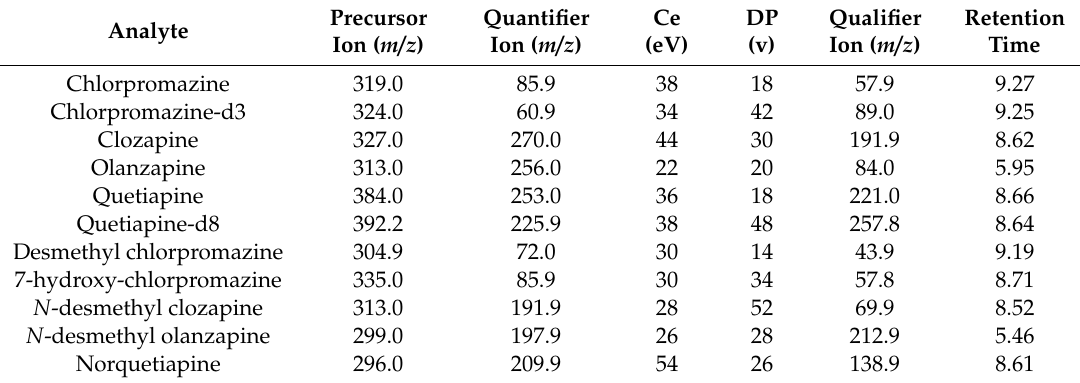
Table 2. Ions transitions, instruments settings, and retention times for each antipsychotic and their